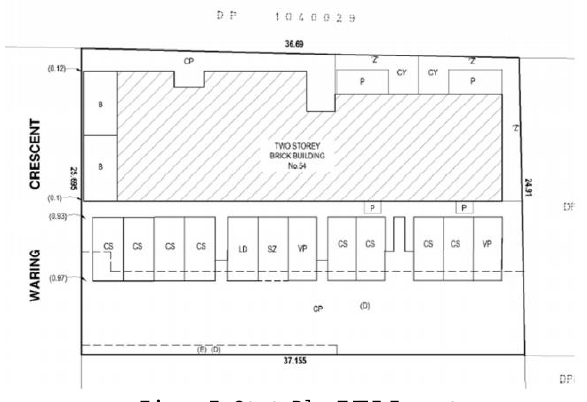
Figure 5 : Opportunities for Digitisation